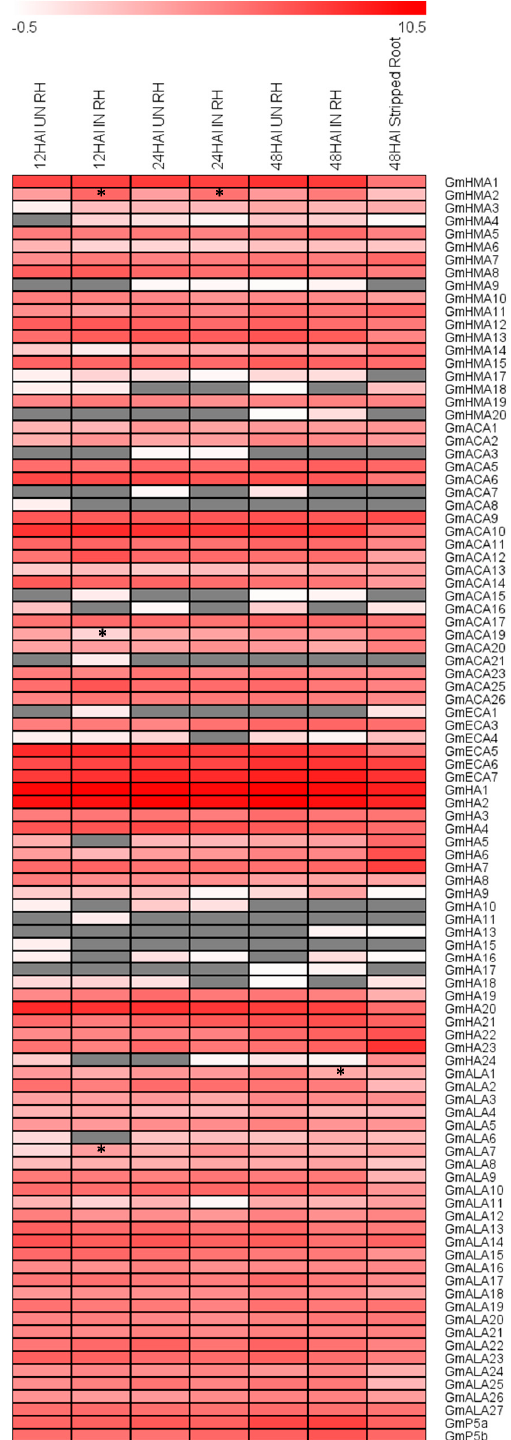
Figure 13. Heatmap representation for the expression profiles of putative genes encoding P-type ATPase proteins in root hairs (RH) and stripped roots inoculated (IN) and mock-inoculated (UN) with Bradyrhizobium japonicum at 12, 24, and 48 h after inoculation (HAI) according to Illumina transcriptome data: the Reads/Kb/Million (RPKM) normalized log2-transformed counts were visualized in the heatmap. The asterisk indicates a significant difference between rhizobia-inoculated RH and mock-inoculated RH at the same time point (an absolute fold change of IN/UN > 2, p - value < 0.05 by binomial test).